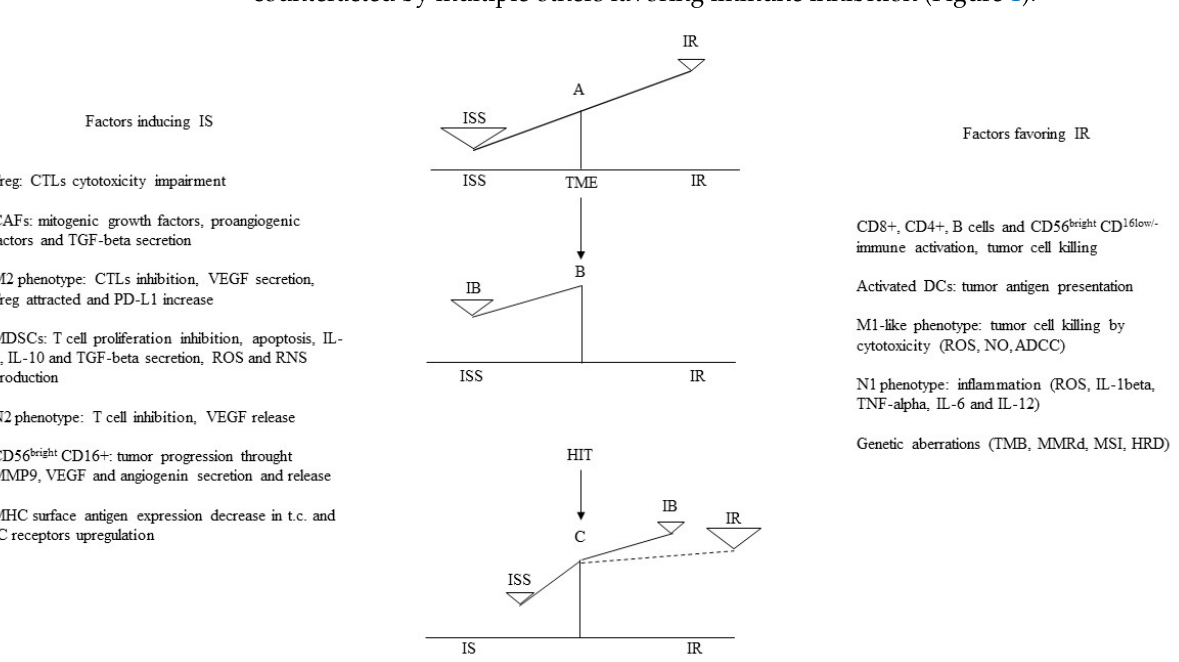
Figure 1. A-B: In TME, factors inducing ISS commonly by far overcome those favoring IR, thus with regard IB, ISS prevails. C: In ER+ metastatic breast cancer patients in clinical benefit during hormone immunotherapy (HIT), SERMs combined with interferon-beta-interleukin-2 sequence (INF-beta-IL-2) counteract tumor proliferation and immune inhibition and stimulate significant immune response [145], therefore IR prevails in TME. ISS: immune suppression; IR: immune response; IB: immune balance; TME: tumor microenvironment; TILs: tumor infiltrating lymphocytes; DCs: dendritic cells; M: macrophage; N: neutrophil; ADCC: antibody-dependent cell-mediated cytotoxicity; Treg: regulatory T cells; CAF: cancer-associated fibroblast; TGF-beta: transforming growth factor beta; CTLs: cytotoxic T cells; VEGF: vascular endothelial growth factor; PD-L1: programmed death ligand 1; MDSC: myeloid derived suppressor cell; IL: interleukin; ROS: reactive oxygen species; NO: nitric oxide; RNS: reactive nitrogen species; MMP-9: matrix metallo proteinase protein 9; MHC: major histocompatibility complex-1; IC: immune checkpoint; TMB: tumor mutation burden; MMRd: mismatch repair deficiency; MSI: microsatellite instability; HRD: homologous recombination deficiency.